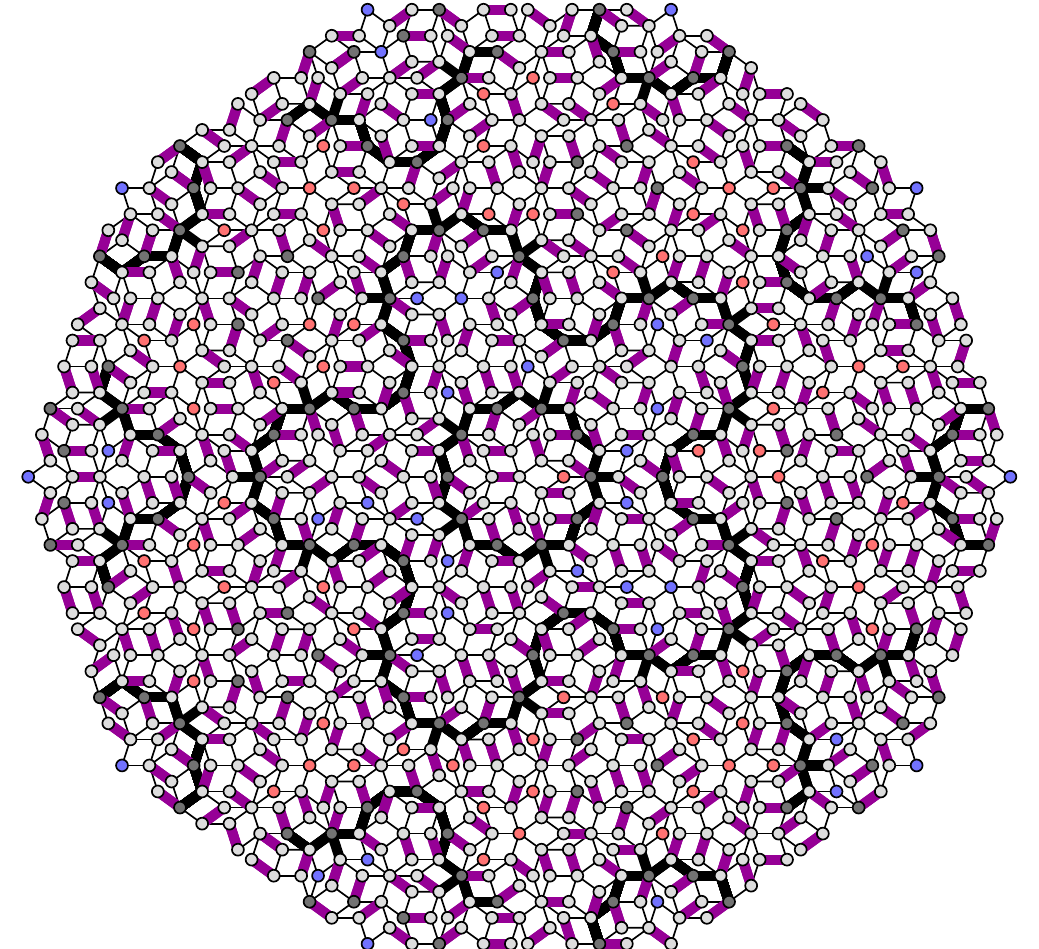
FIG. 7. A maximum matching of a finite section of the Penrose tiling. Certain edges (thick black lines) of even-valence vertices (dark gray) cannot be covered by dimers (purple) in maximum matchings. Monomers colored blue or red according to their bipartite charge cannot cross the closed thick black